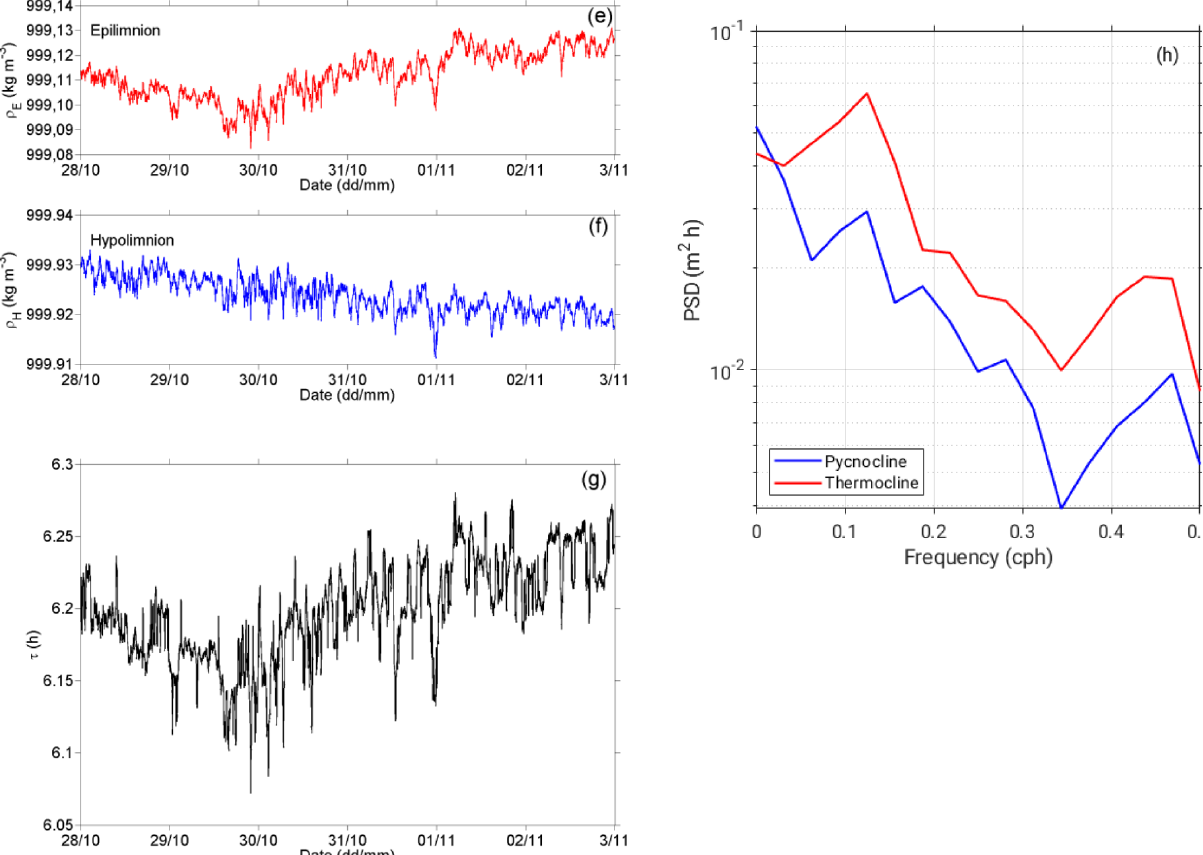
Figure 7. Observed wind speed (a) , wind direction (b) , and lake temperature at 15m (c) from 23 October to 5 November (both at 00:00LST). Four southeasterly wind episodes are outlined using different colors in panels (a) and (b) . PSDs for the lake temperatures at depths from 0.2 to 43m (d) and for the pycnocline and thermocline depths (h) are calculated for the period from 28 October to 3 November (both at 00:00LST), as described in Sect. 3.2, except for the window length (WL). Here, the WL is set to WL = 32 due to the short input time series. Panels (e) and (f) show the water density (kgm − 3 ) in the epilimnion and hypolimnion from 28 October to 3 November, whereas the period